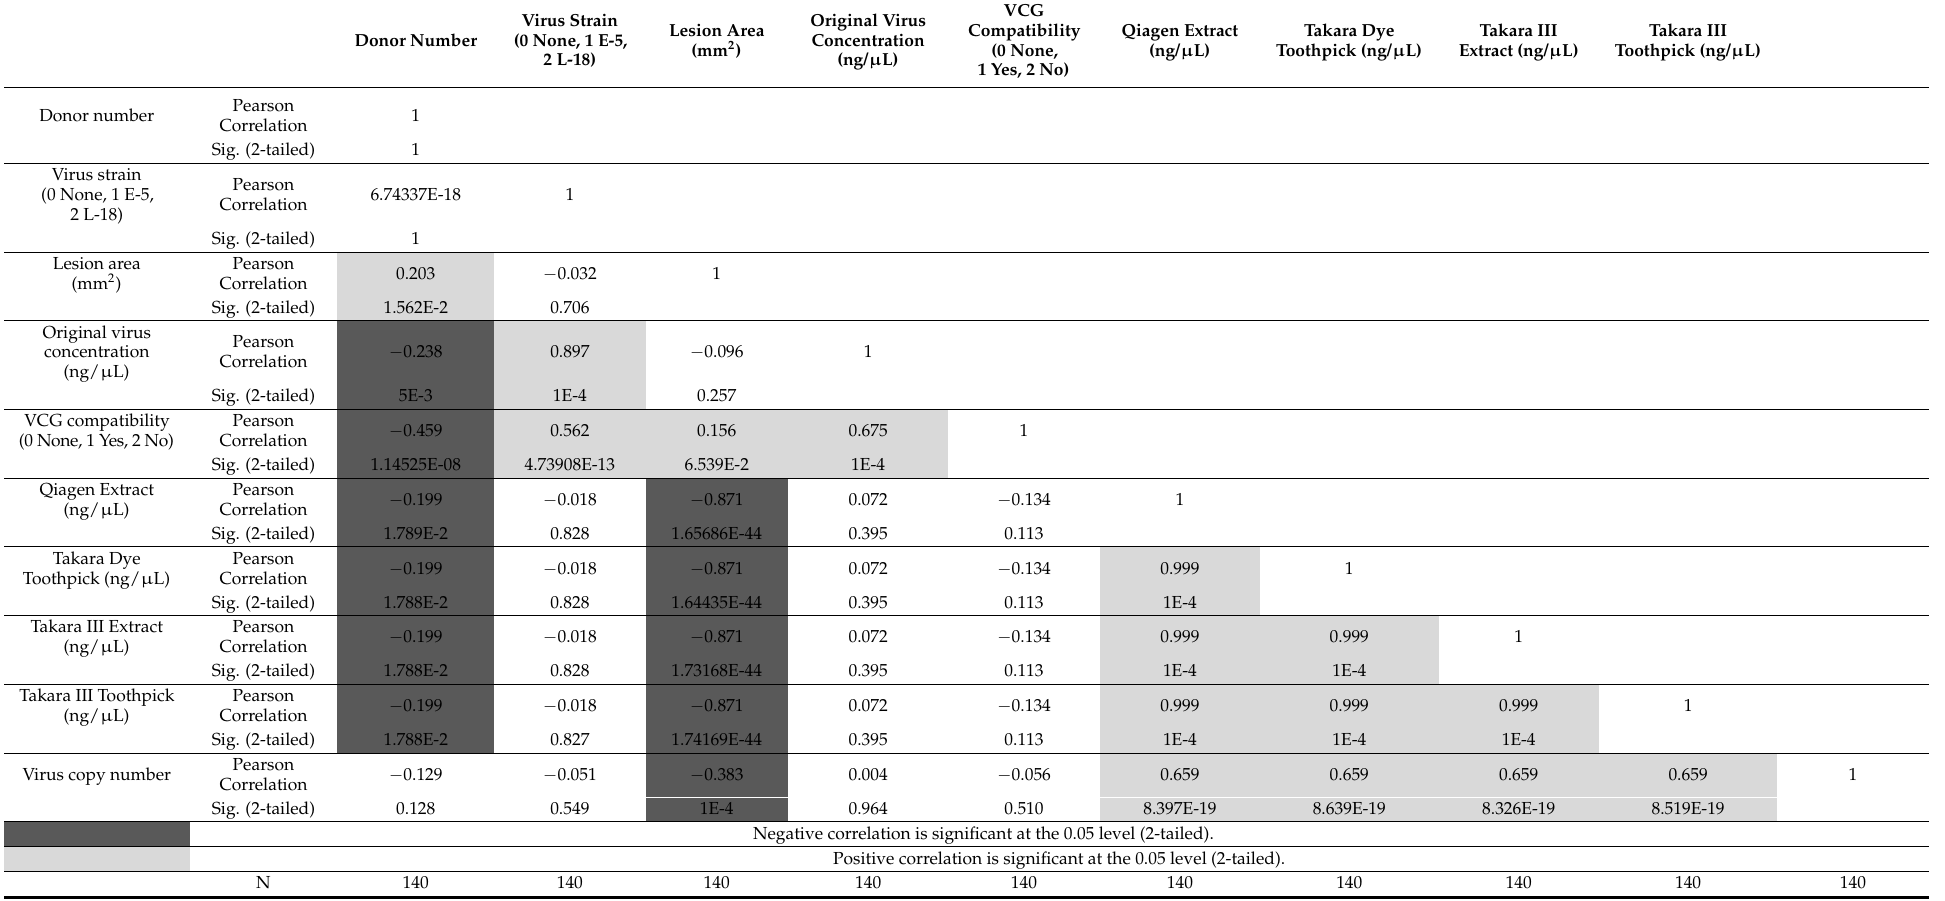
Table 5. Correlation results among all the tested parameters in assay II, using branches. ASSAY II